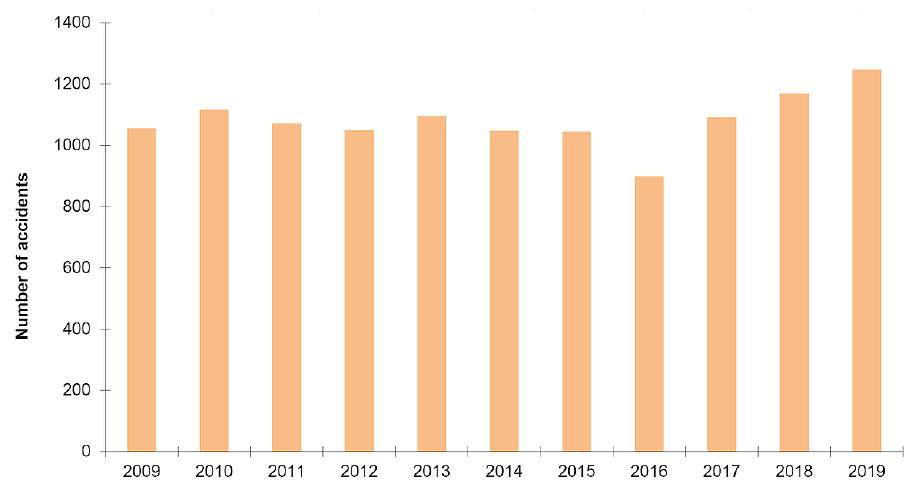
Figure 1. Number of rail accidents in Canada, 2009 to 2019 [1].